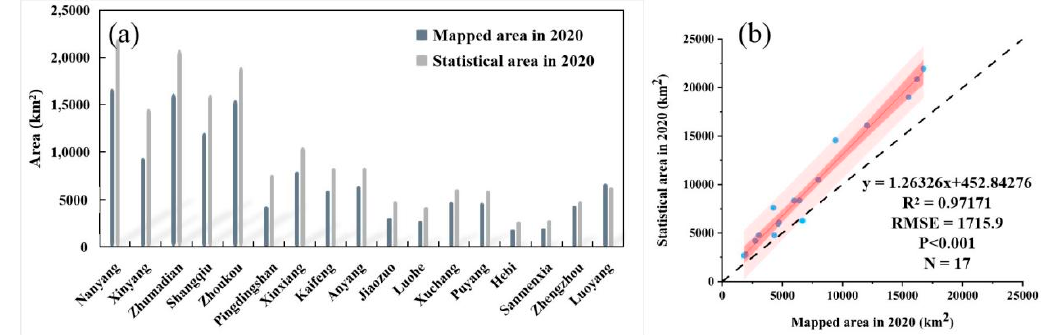
Figure 8. ( a ) A comparison of sown area estimates by city between the cropping intensity map in 2020 and the agricultural statistical data reported for 2020. ( b ) The black dotted line is the y = x line, and the red area represents the 95% confidence interval and prediction zone.